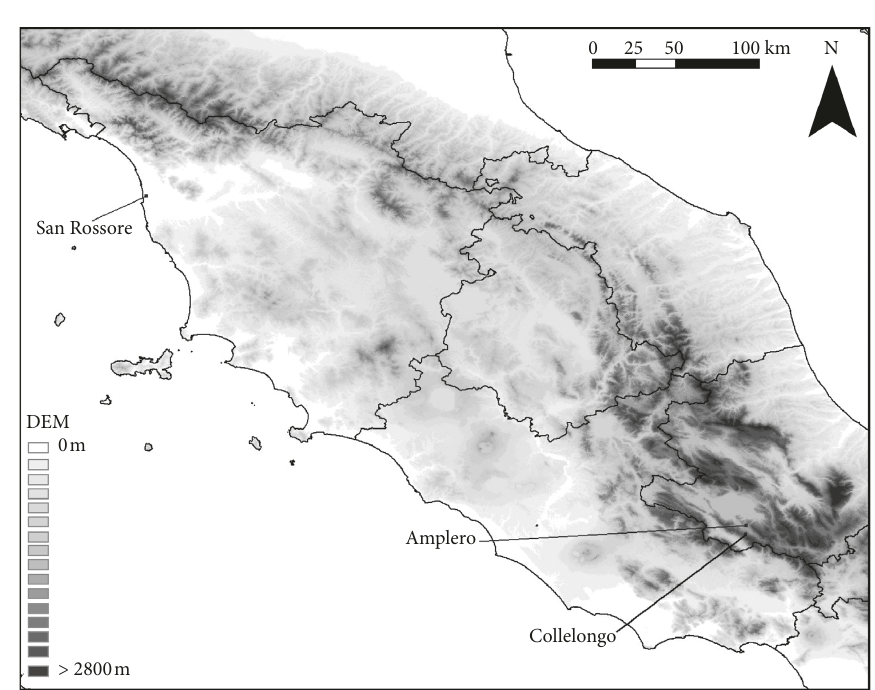
Figure 2: Digital elevation model (DEM) of Central Italy showing the geographical position of the three study